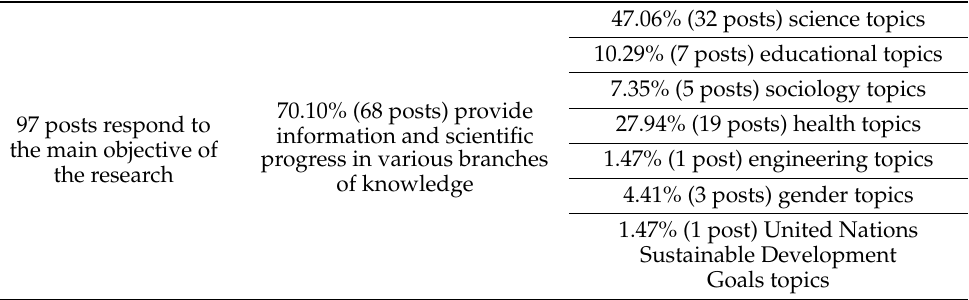
Table 4. Analysis of the